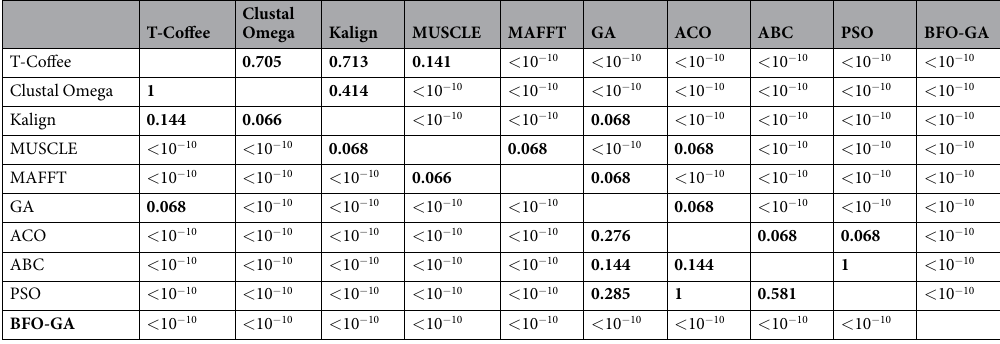
And also the RF distance is used to measure the smallest distance between trees to see the better inferred trees. Table 2 summarizes the results of RF distances predicted by the ClustalW2. The minimum distances in each row are indicated in bold. The results inferred that the phylogenetic trees inferred from the BFO-GA resulting alignments has the smallest distances in five of eight databases. One of the common performances metric for